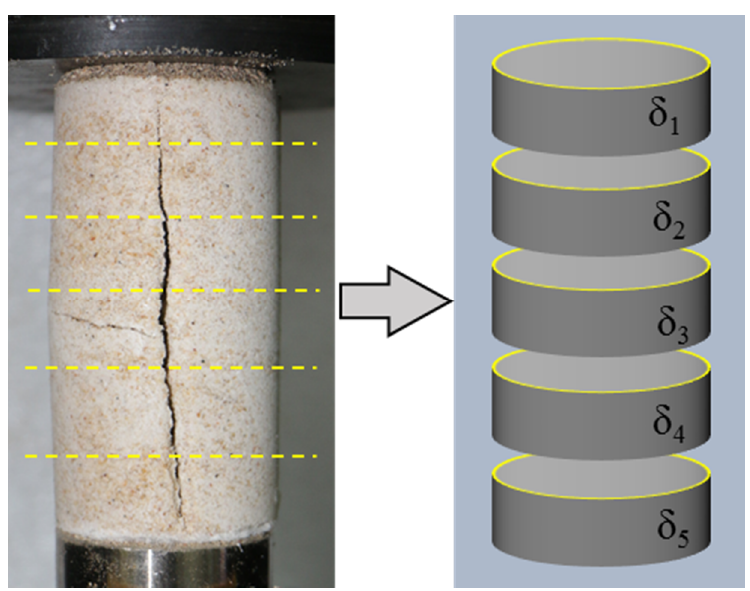
Figure 5. The layering diagram of the bio-treated subsamples along the horizontal direction.